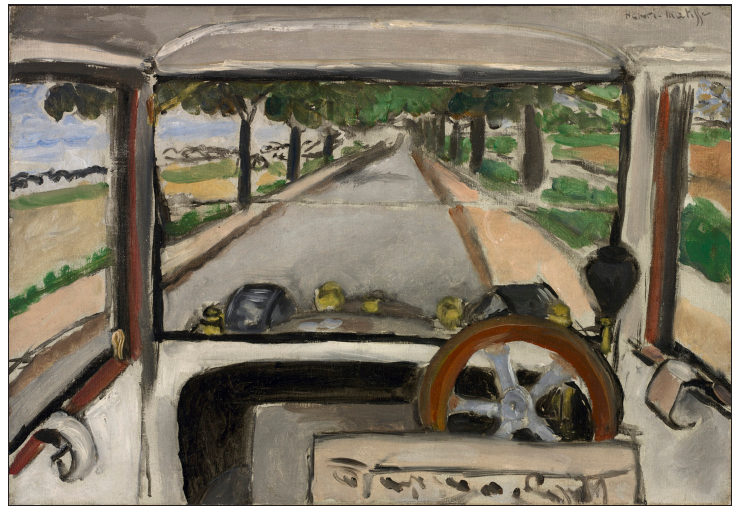
Fig. 8 : Henri Matisse, The Windshield, On the Road to Villacoublay , 1917, oil on canvas, 38.2 × 55.2 cm, Cleveland Museum. Bequest of Lucia McCurdy McBride in memory of John Harris McBride II 1972.225. © Succession H. Matisse/Artists Rights Society (ARS), New